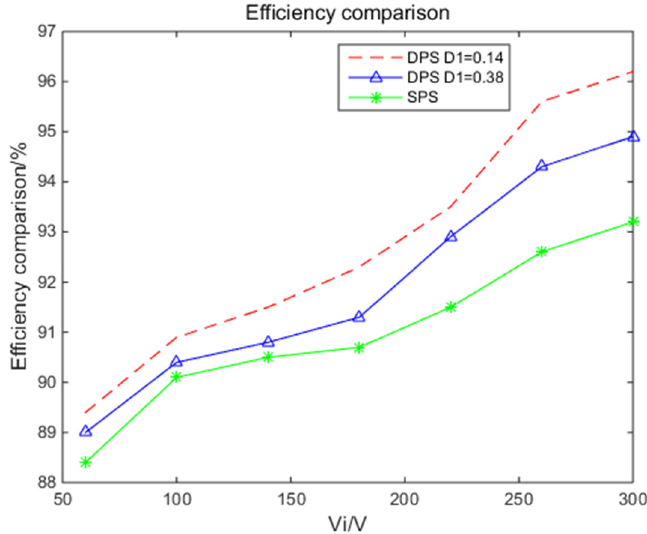
Figure 12. Comparison of converter efficiency under different controls.